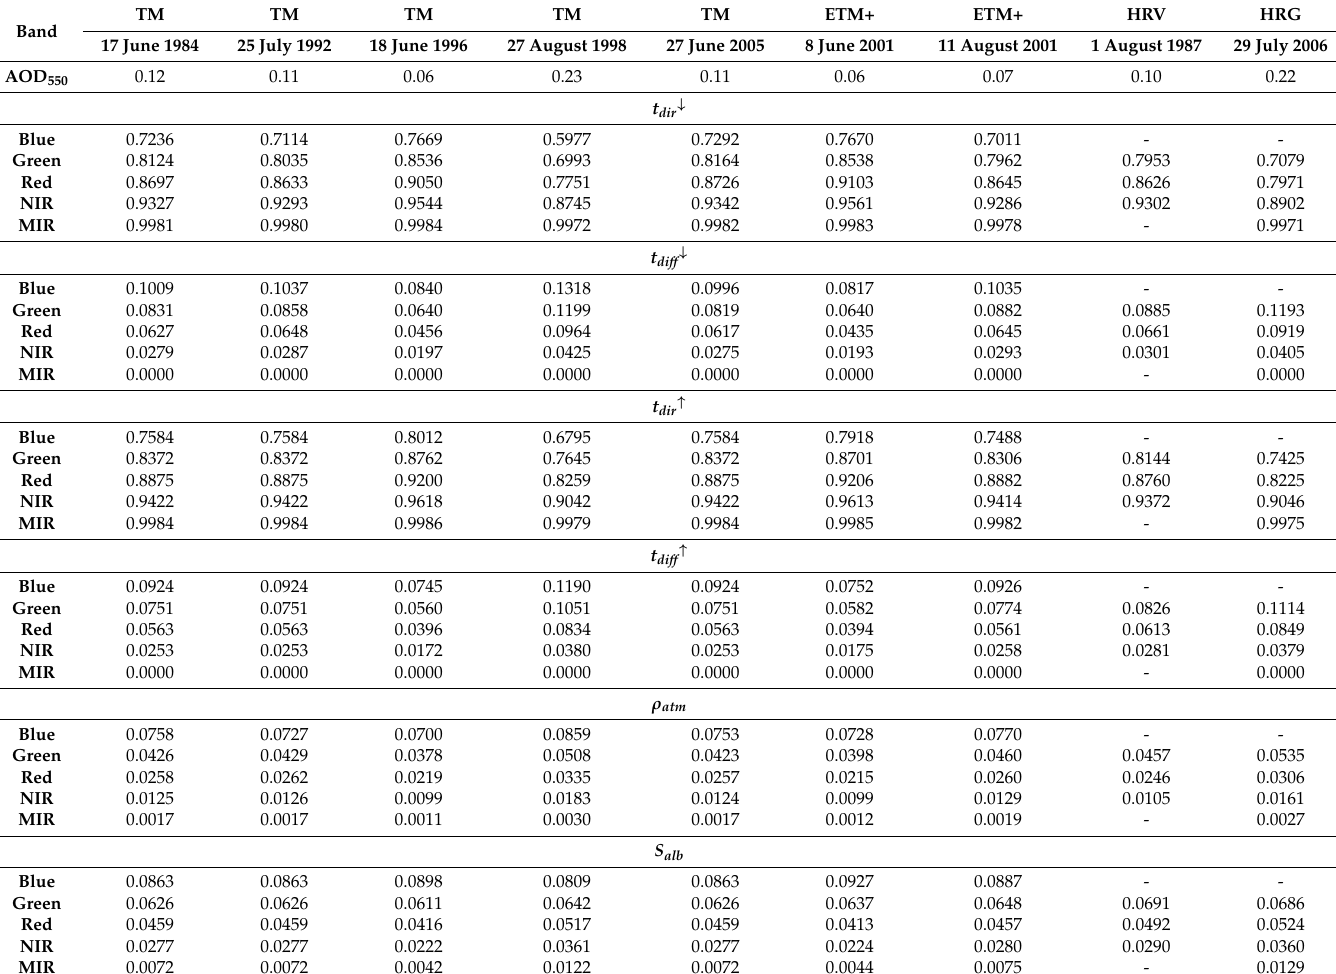
Table 2. AOD values calculated with REFLECT dark objects method and corresponding atmospheric parameters ( t dir ↓ , t diff ↓ , t dir ↑ , t diff ↑ , ρ atm , and S alb ) for Landsat and SPOT images used for